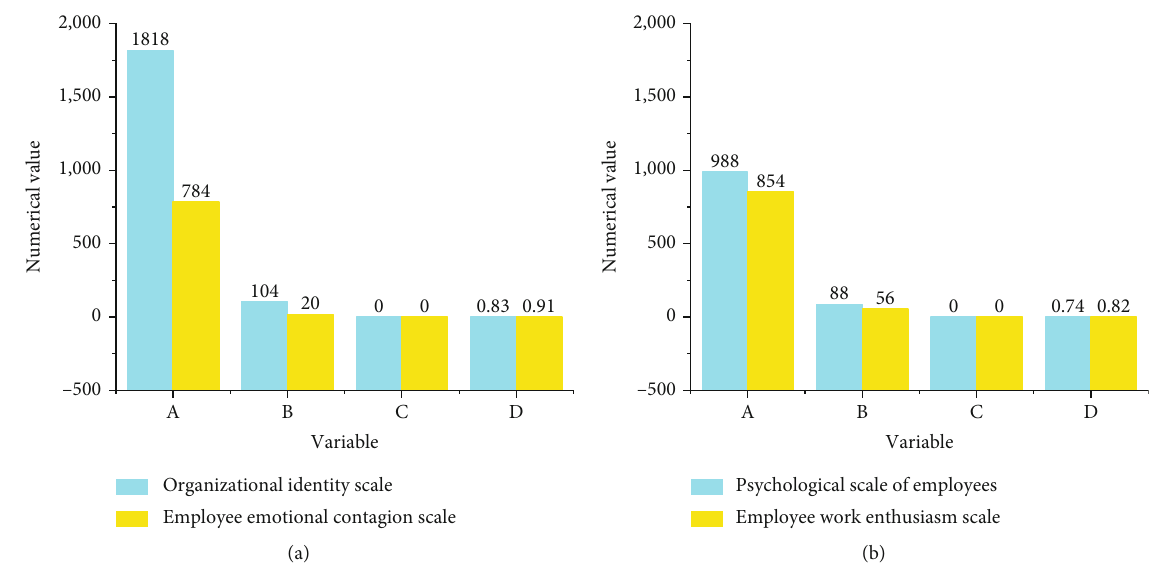
Figure 4: Validity analysis (a) validity analysis of organizational identi fi cation scale and employees ’ emotional contagion scale. (b) Validity analysis of employees ’ mental health scale and employees ’ work enthusiasm scale. A: approximate chi-square. B: degree of freedom. C: signi fi cance. D: the statistical test of the four scales).